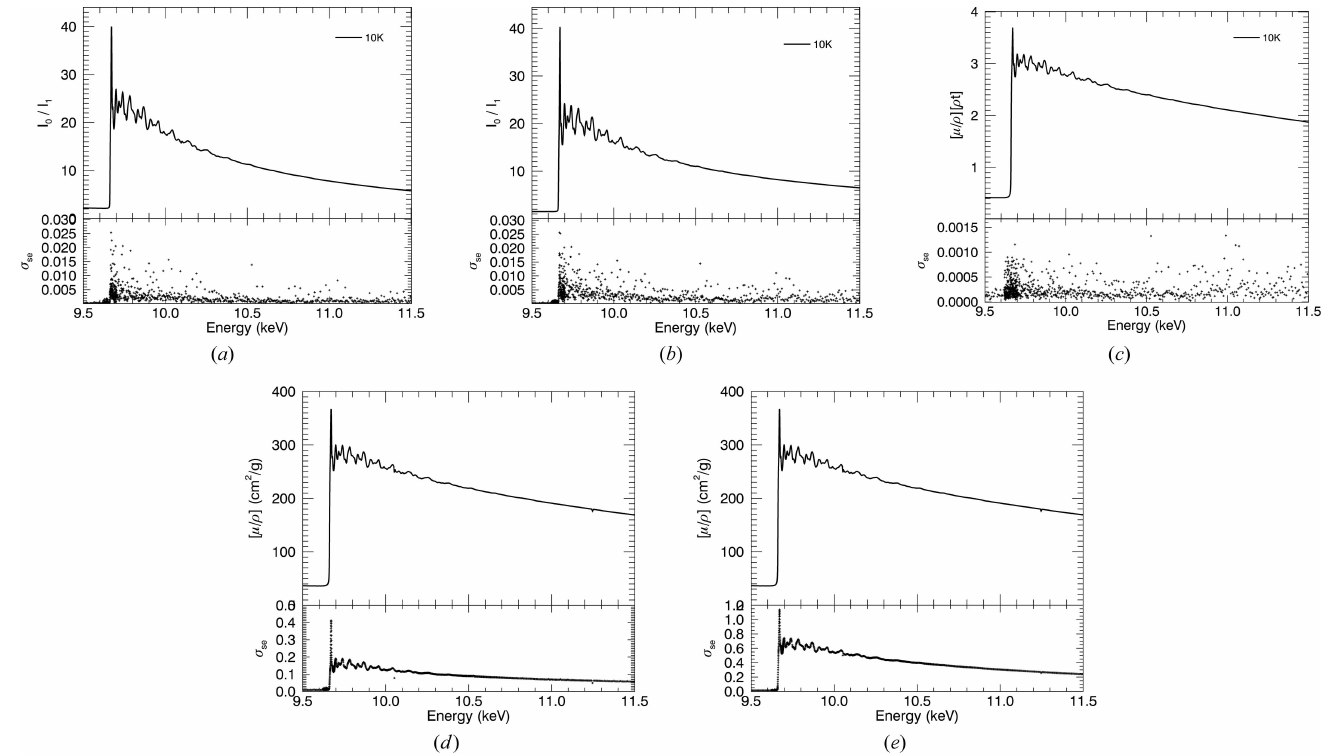
Figure 9 Summary of the progression of systematic corrections and the associated standard error after each correction, for 10 K. ( a ) Ratio of raw counts of upstream and downstream ion chambers with standard error derived from repeated measurements. ( b ) Ratio of ion chambers after correction for dark current. ( c ) [ (cid:3) / (cid:2) ][ (cid:2) t ] from taking the logarithm of ( b ). ( d ) Converting to units of the mass attenuation coefficients and correcting for scattering, according to equation (14). ( e ) Corrected measurements with roughness correction and corresponding uncertainty.